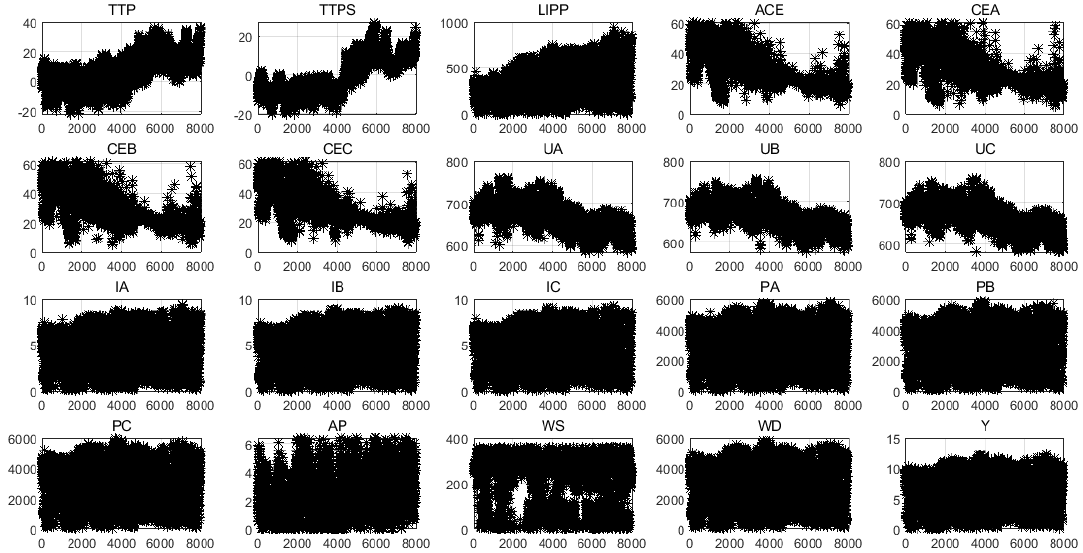
Figure 7. Visual analysis of 20 variables after data cleaning.